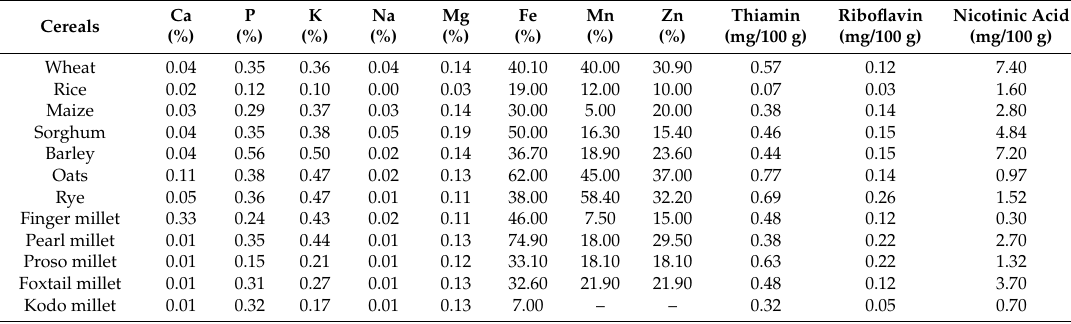
Table 3. Mineral composition of the millets and other